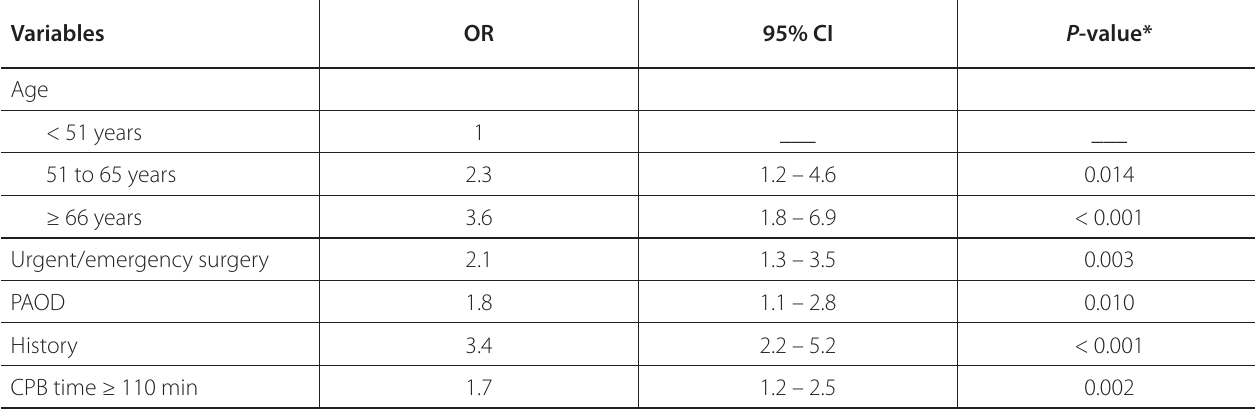
Table 2 . Logistic regression (data for the entire sample, n=4,862). Variables